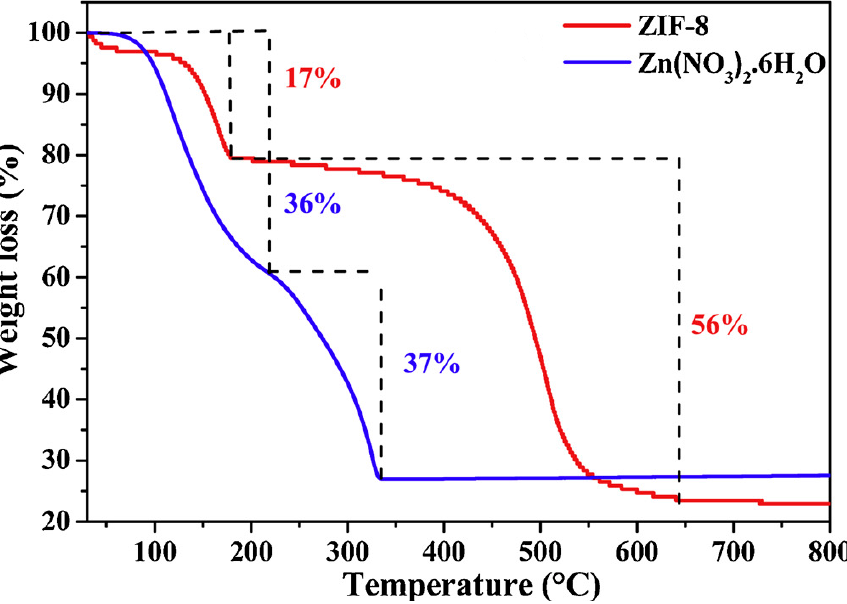
Figure 3. Comparison of TGA profile of semi-conducting ZnO synthesized with a ZIF-8 template by pyrolysis (blue curve) and with ZIF-8 (red curve)